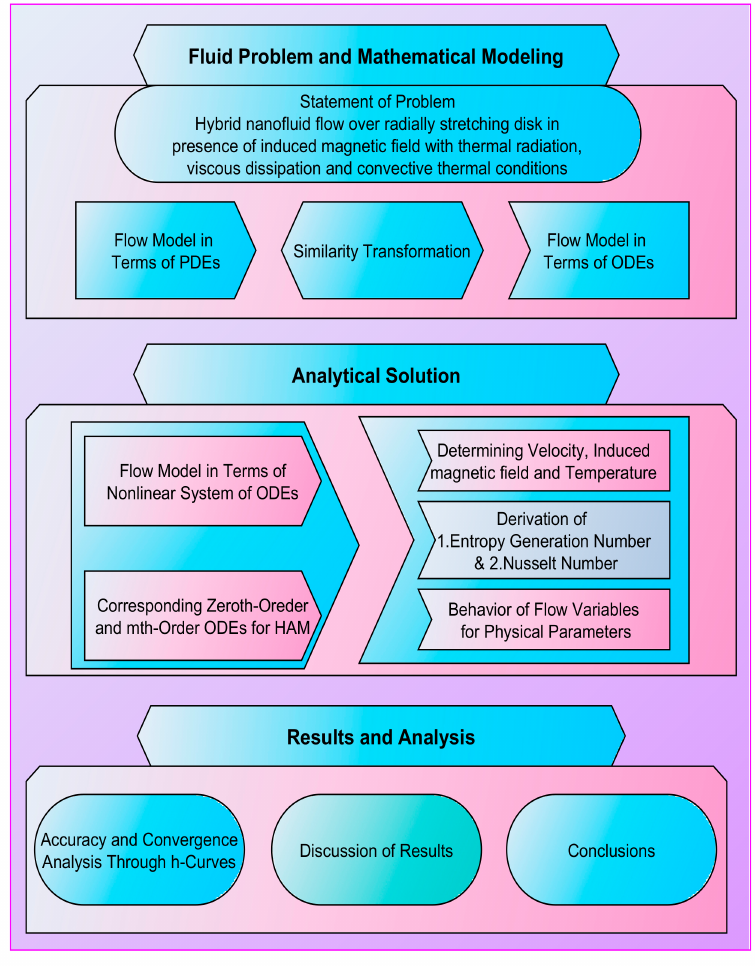
Figure 1. Workflow